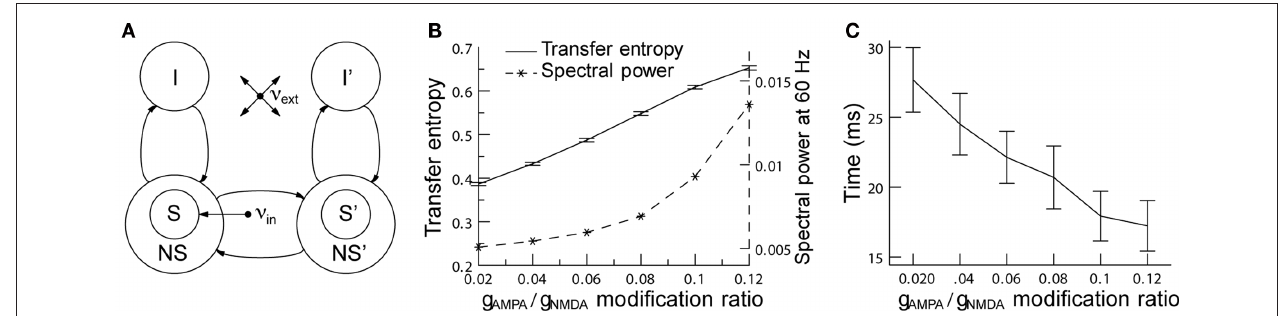
Figure 4 | increasing network gamma frequency band power leads to spontaneous activity in the surrounding cerebral cortex. (B) When the mean transfer entropy increase and time for information transfer decrease. modification ratio g / g increases, both gamma power (dashed line) and TE AMPA NMDA (A) Schematic representation of the network. The network consists of two (solid line) increase. (C) Rise times of TE as a function of the modification ratio. parts. In each part, there are excitatory (S, NS) and inhibitory (I) spiking neuron Information starts flowing after stimulus onset when, consequently, TE starts pools, which are interconnected. The connectivity is full. The selective pool (S) rising. The plot shows the time required to reach 50% of the average TE. TE receives the external input ( ν clearly rises faster for higher gamma band power. In both graphics, error bars ) and has strong recurrent connections. The two in indicate 95% confidence intervals; averaged over 100 trials. Figure adapted from parts of the network are connected via the selective pools by both feedforward Buehlmann and Deco (2010). and feedback connections. All neurons get also an input ( ν ) that simulates the ext